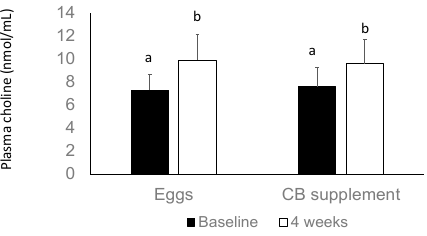
Figure 2. Concentrations of plasma choline at baseline (dark bar) and following the intervention (white bar). Different superscripts (a,b) indicate significantly different from each other ( p < 0.001). Data are presented as mean + SD for n = 23 subjects.